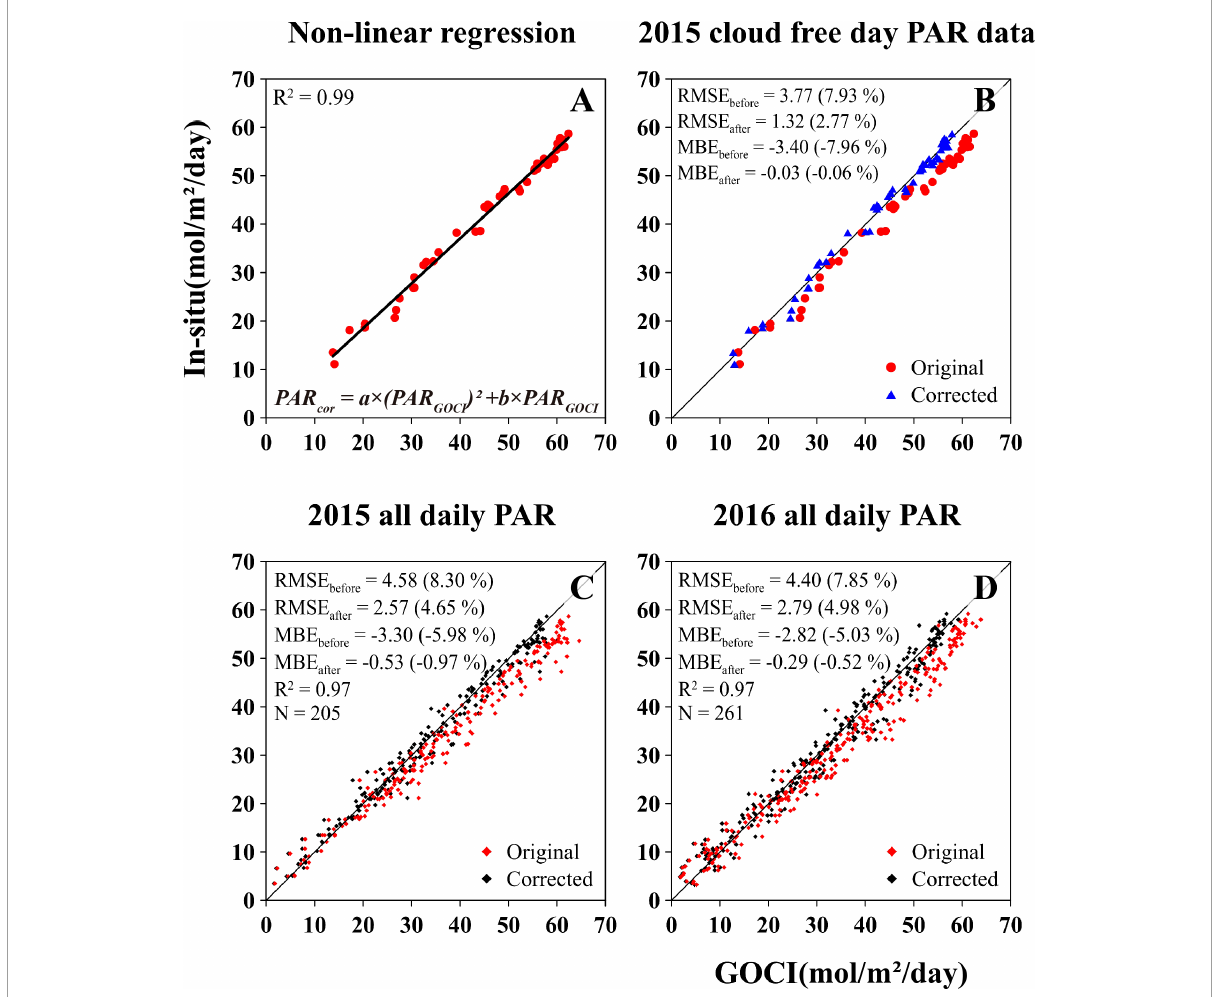
FIGURE 4 Nonlinear data correction was conducted using data collected under cloud-free conditions. Daily PAR at each station in 2015 was calculated using data from cloud-free pixels. (A) Linear regression of clear-sky data for 2015, where a and b in the equation are 7.0 × 10 –5 and 0.9233, respectively. (B) Comparison of original GOCI PAR values and those corrected using clear-sky data for 2015. (C) Comparison of all-day PAR values calculated using original and corrected GOCI data for 2015. (D) Comparison of PAR data for